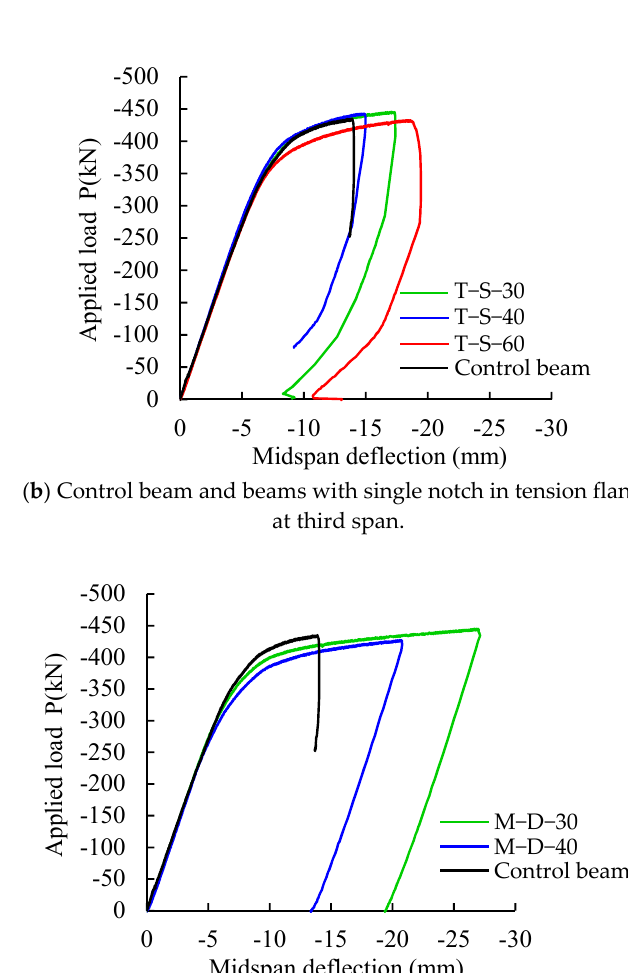
( c ) Control beam and beams with single notch in tension ( d ) Control beam and beams with double notches in tension flange at mid span. flange at mid span. Figure 5. Experimental applied load–midspan deflection relations. Figure 5. Experimental applied load–midspan deflection